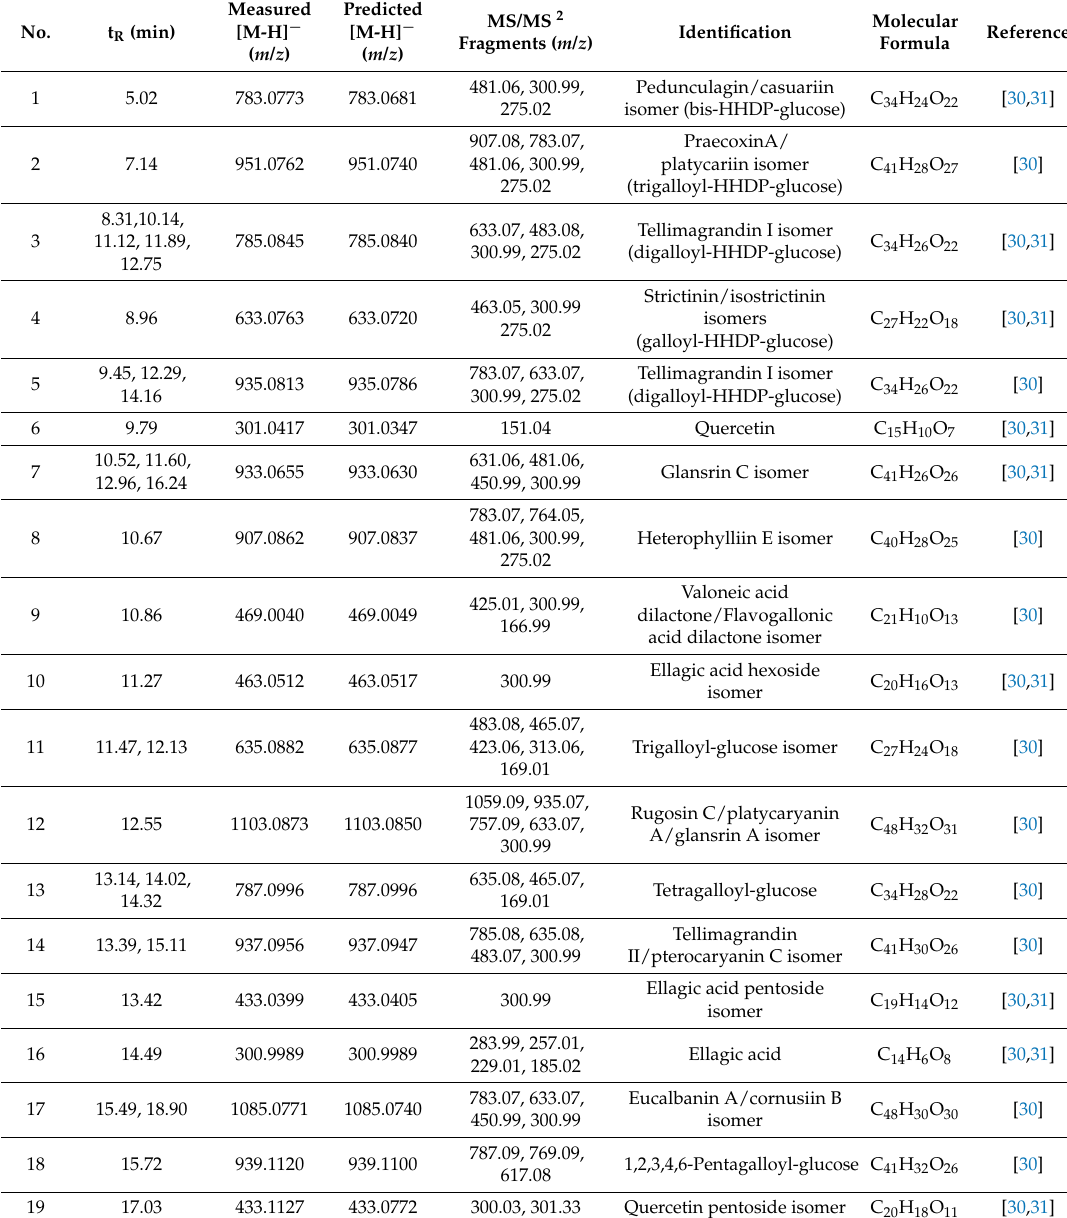
Table 1. Identification of phenolic compounds in walnut polyphenol extract (WPE) using HPLC-ESI-IT-TOF-MS 1 in the negative ion